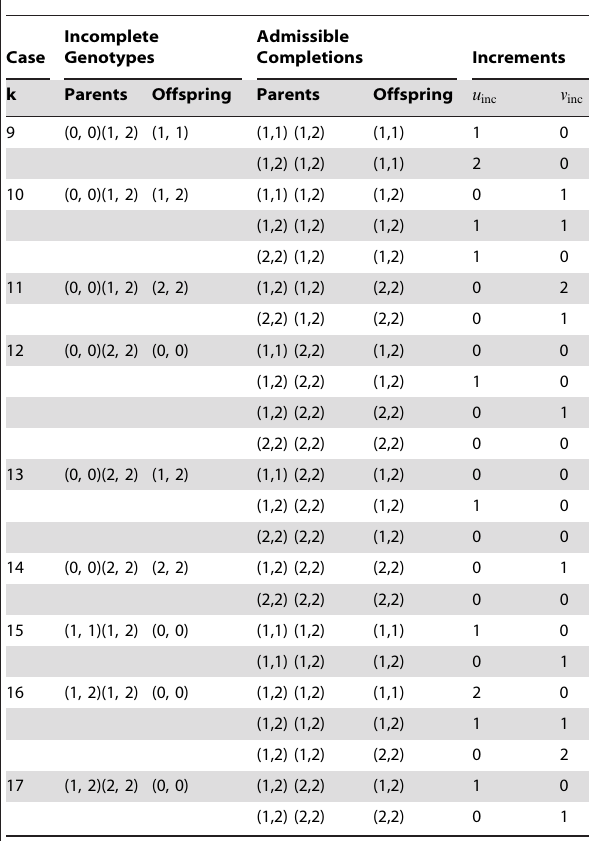
Table 5. List of admissible completions for cases